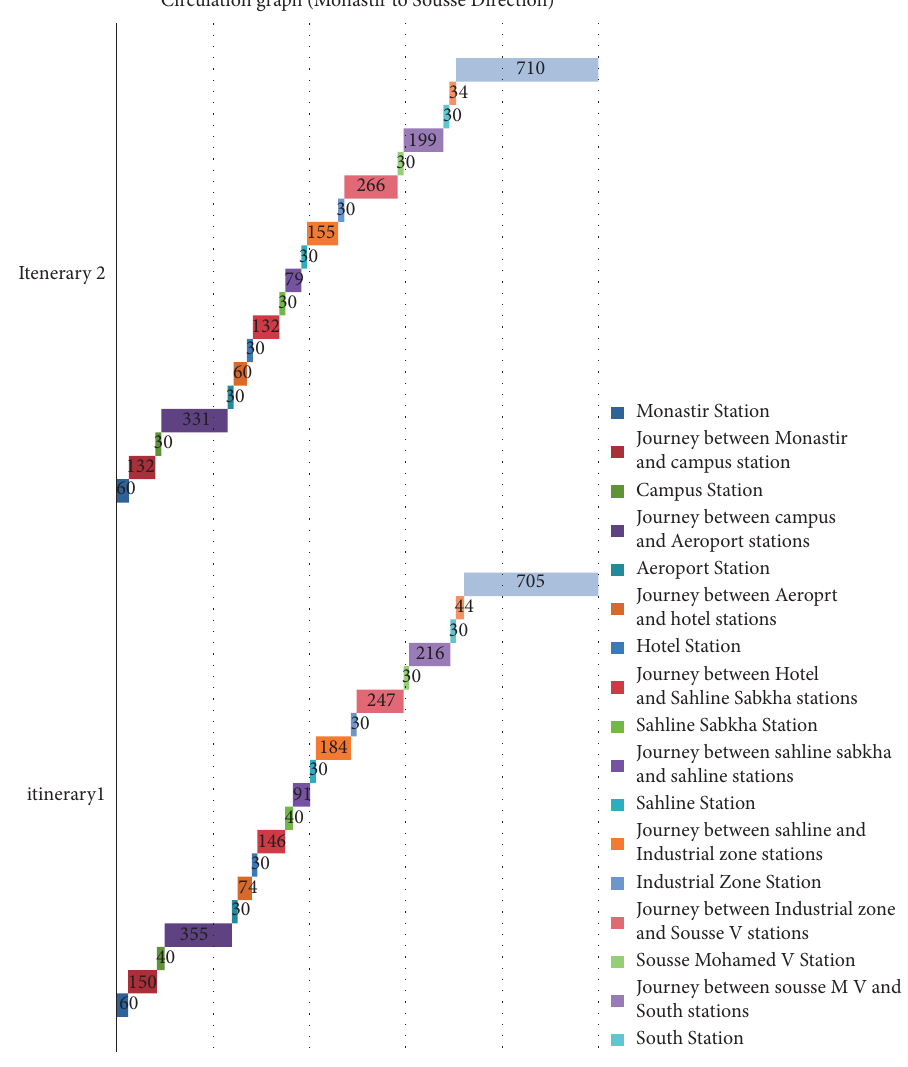
Figure 8: Circulation graph (Monastir to Sousse